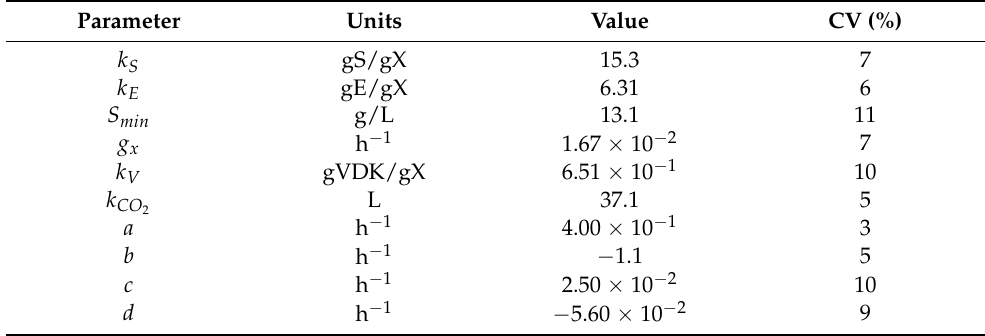
Table 5. Parameter estimate values and coefficients of variation (CV) for the biomass model.